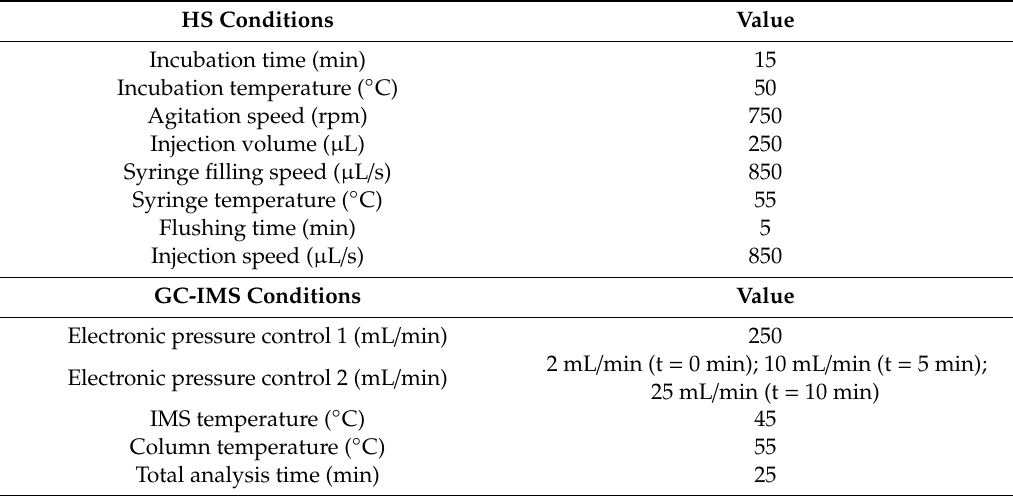
Table 2. Conditions used for the analysis of samples in headspace–gas chromatography–ion mobility spectroscopy